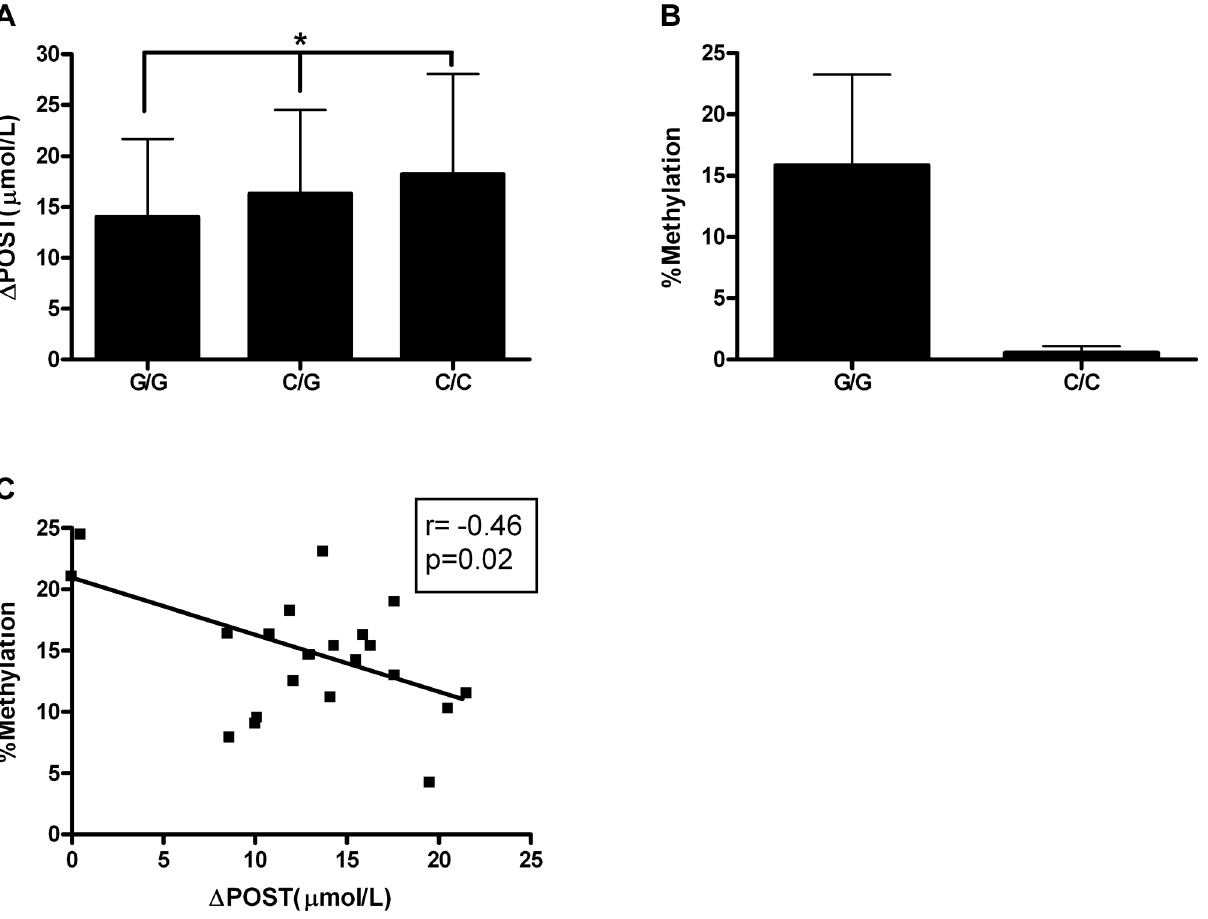
Figure 4. Epigenetic Evaluation of rs11752813. (A) Average D POST ( m mol/L) in VISP trial based on rs11752813 genotype. (*) p , 0.001 by one- way ANOVA and all genotypes are significantly different by students t-test. (B) Percent methylation analyzed by bisulfite pyrosequencing of n=23 individuals (G/G) and n=6 individuals (C/C). (C) Linear regression analysis of percent methylation of rs11752813 based on genotype and D POST ( m